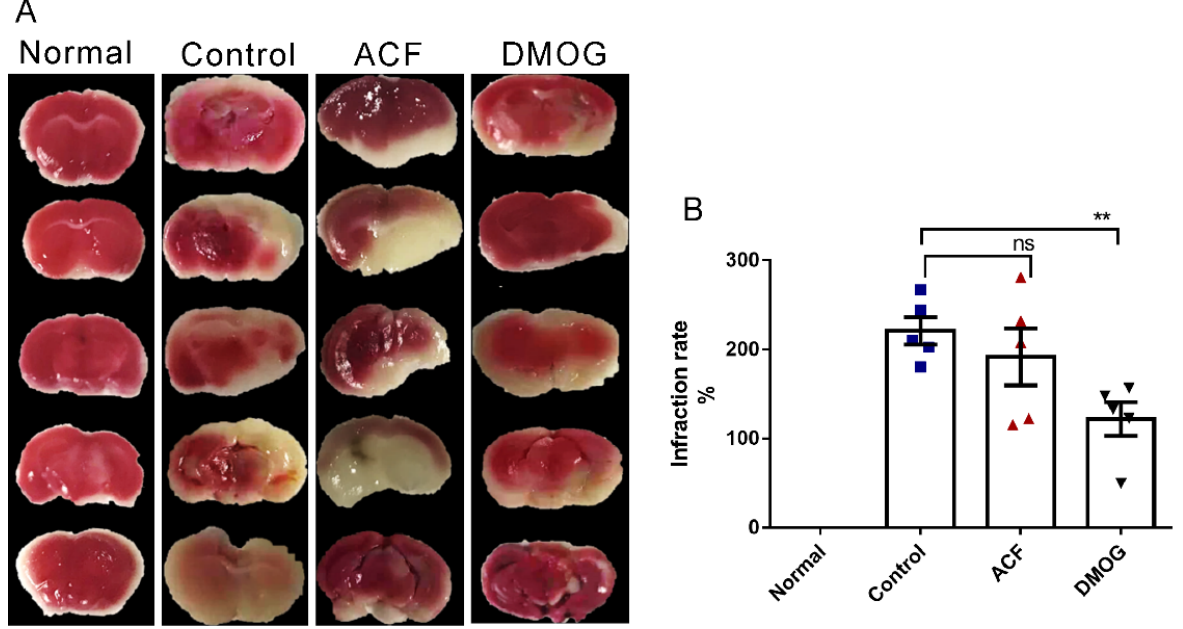
Figure 3. HIF-1 α reduces the infarct volume following ET-1 injection. ( A ) TTC staining 24 h post ET-1 injection. ( B ) Infraction area rate, ACF vs. control p = ns, DMOG vs. Control: ** p < 0.01. All values are expressed as mean ± SEM, each group, one-way ANOVA, followed by post hoc Tukey test n = 5.